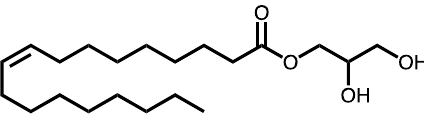
Figure 1. Chemical structure of monoolein (MO).